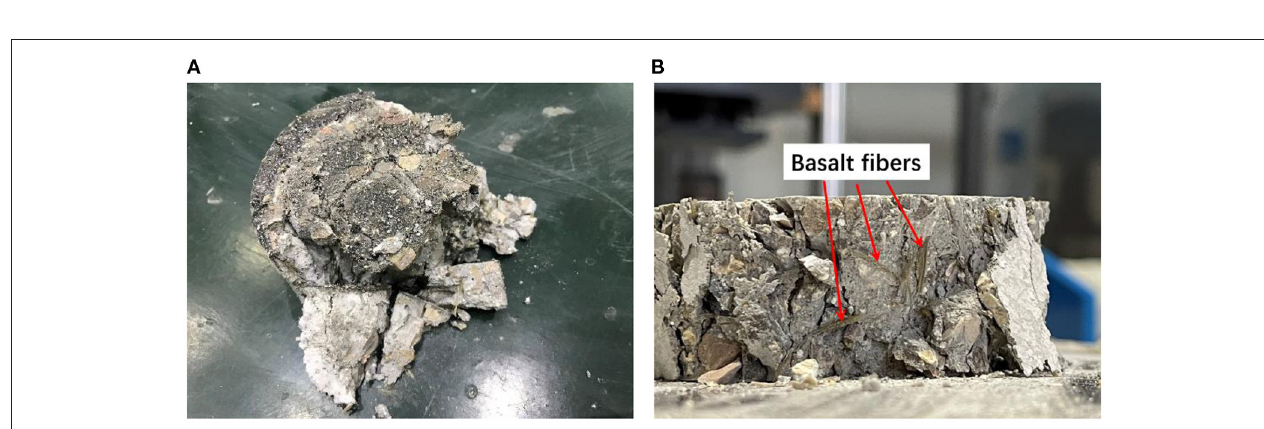
FIGURE 4 | Illustration of the failure mode of BFRAAC under dynamic compression at strain rate of 129.67 s − 1 . (A) Damage and integrity of specimen after impact. (B) Fiber distribution in the matrix.